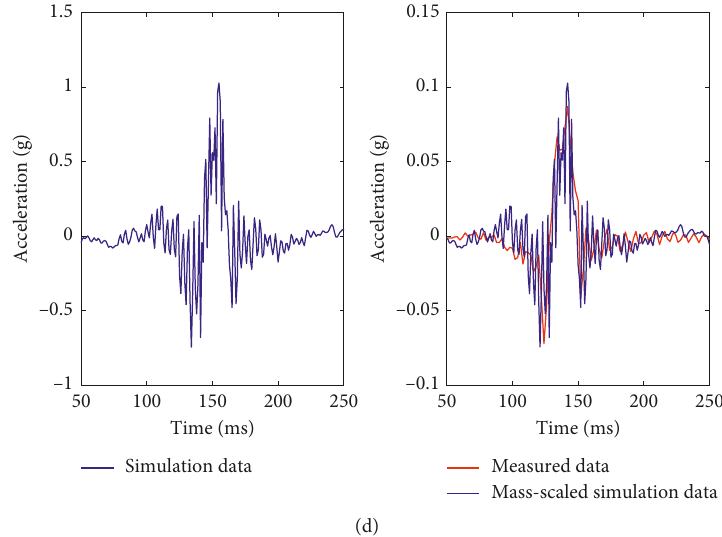
Figure 8: The comparison between simulated data and measured data (blue curves are simulated data and red curves are measured data). (a) The comparison of vertical strain. (b) The comparison of longitudinal strain. (c) The comparison of transverse strain. (d) The comparison of vertical acceleration.